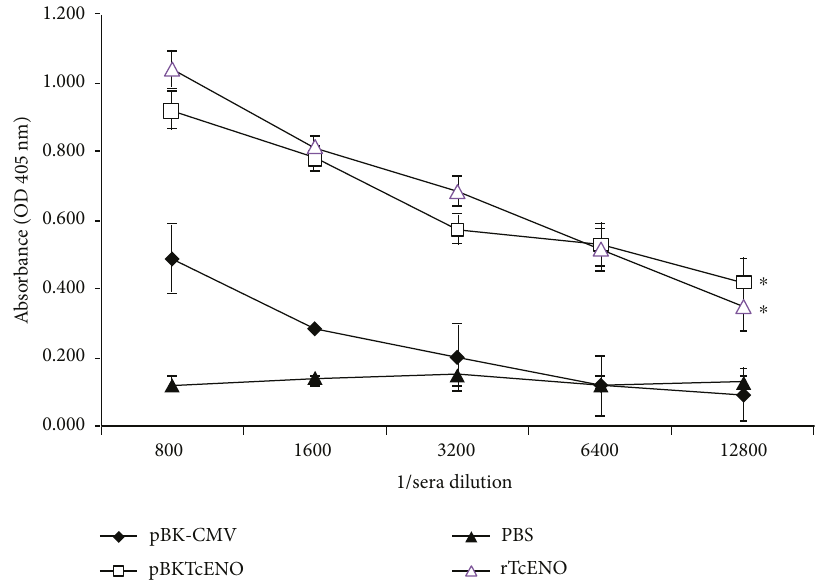
Figure 2: Antibody titers in immunized mice. ELISA was performed seven days after the last immunization to evaluate the serum levels (absorbance in optical density at 405nm) of rTcENO-speci fi c antibodies at di ff erent dilutions. The values represent the average of triplicate assays ± S.D. A signi fi cant di ff erence was detected by comparing rTcENO or pBKTcENO versus PBS or pBK-CMV ( ∗ p < 0 01 ).